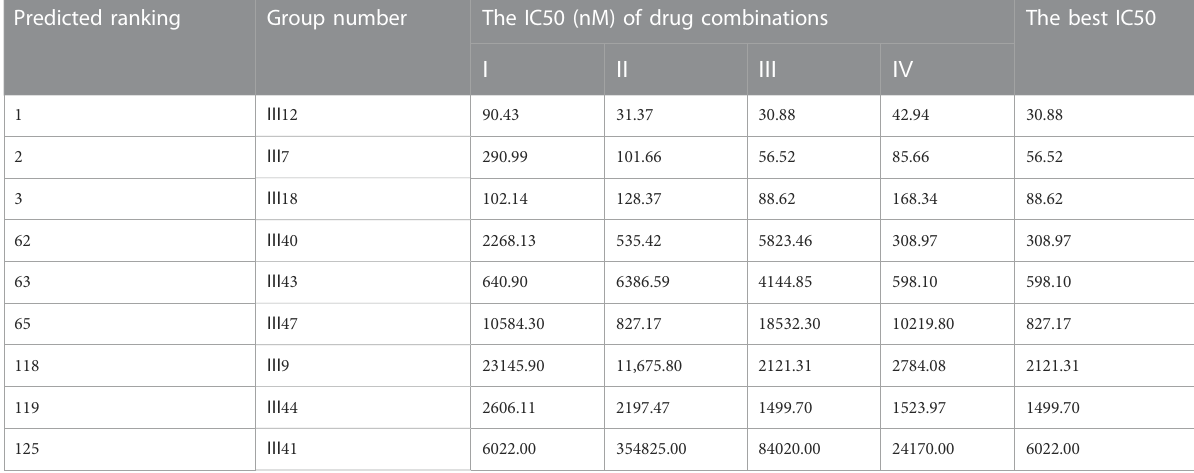
TABLE 5 The anti-cancer effects of nine combinations of three drugs on MCF-7 cells. Predicted ranking Group number The IC50 (nM) of drug combinations